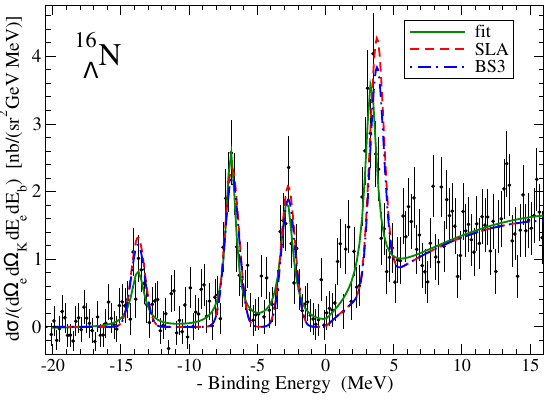
Figure 2. 16 O( e , e (cid:48) K + ) spectrum of 16 Λ N from JLab Hall A measurements. Figure adapted from Ref.